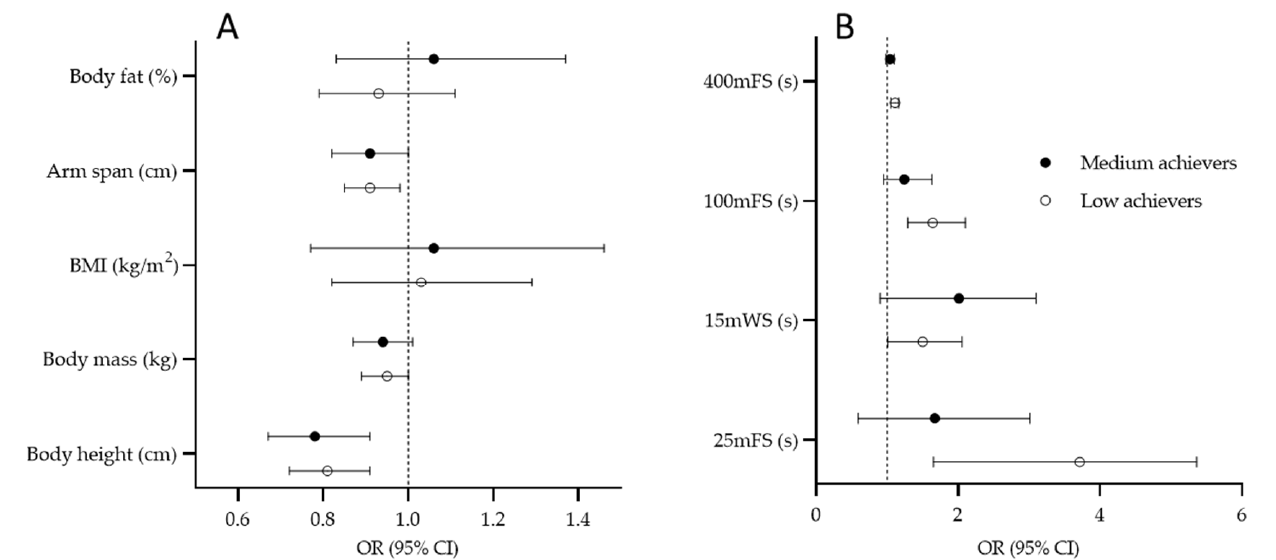
Figure 2. Results of the multinomial logistic regression for criterion “success at senior level” with high-achievement group as reference value for anthropometric predictors ( A ) and swimming predictors; ( B ) total sample (BMI, body mass index; 25 mFS, 25 m freestyle swimming; 15 mWS, 15 m water polo swimming; 100 mFS, 100 m freestyle swimming; 400 mFS, 400 m freestyle swimming).